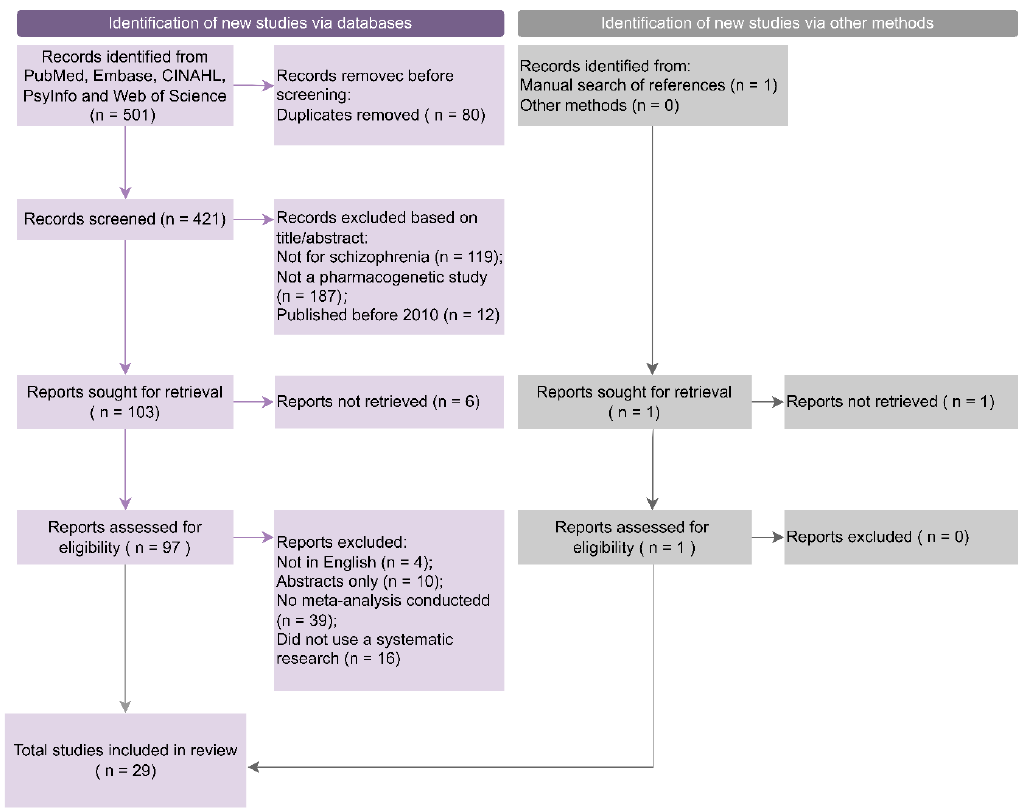
Figure 1. PRISMA flowchart of study selection and inclusion process.